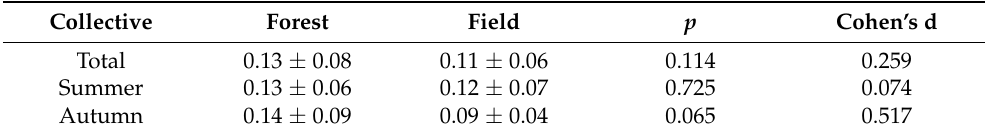
Table 5. Cortisol ( µ g/dL) in saliva ( n = 39).